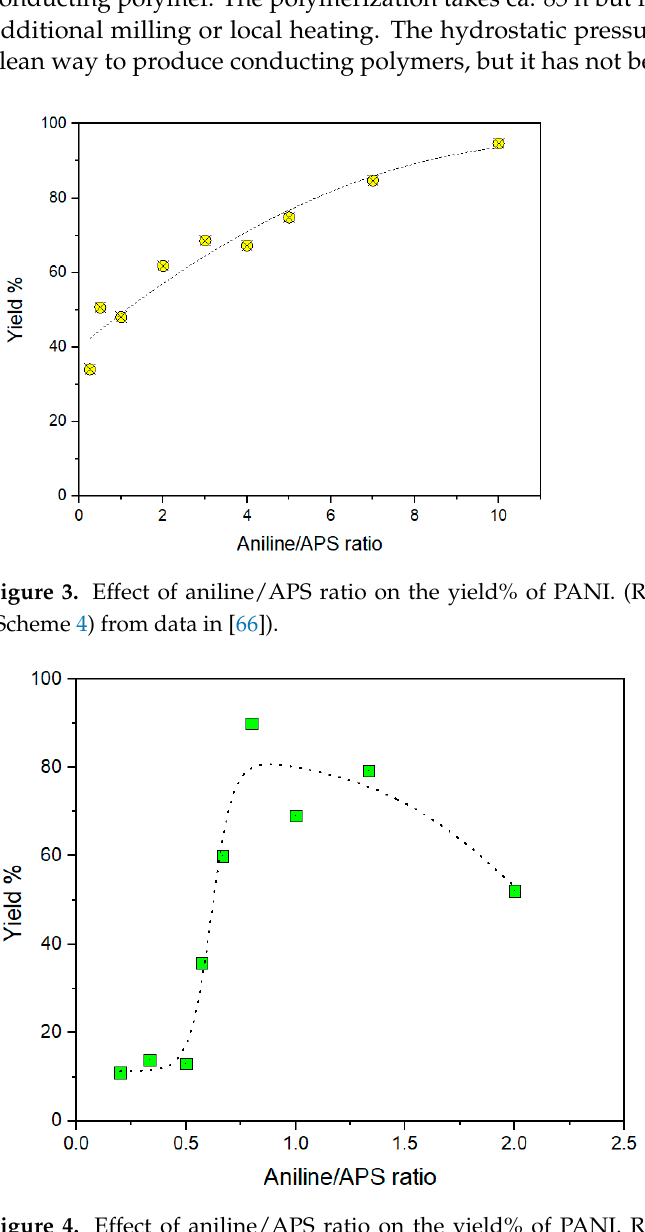
Figure 4. Effect of aniline/APS ratio on the yield% of PANI. Recalculated using stoichiometry (Scheme 4) from data in [69].